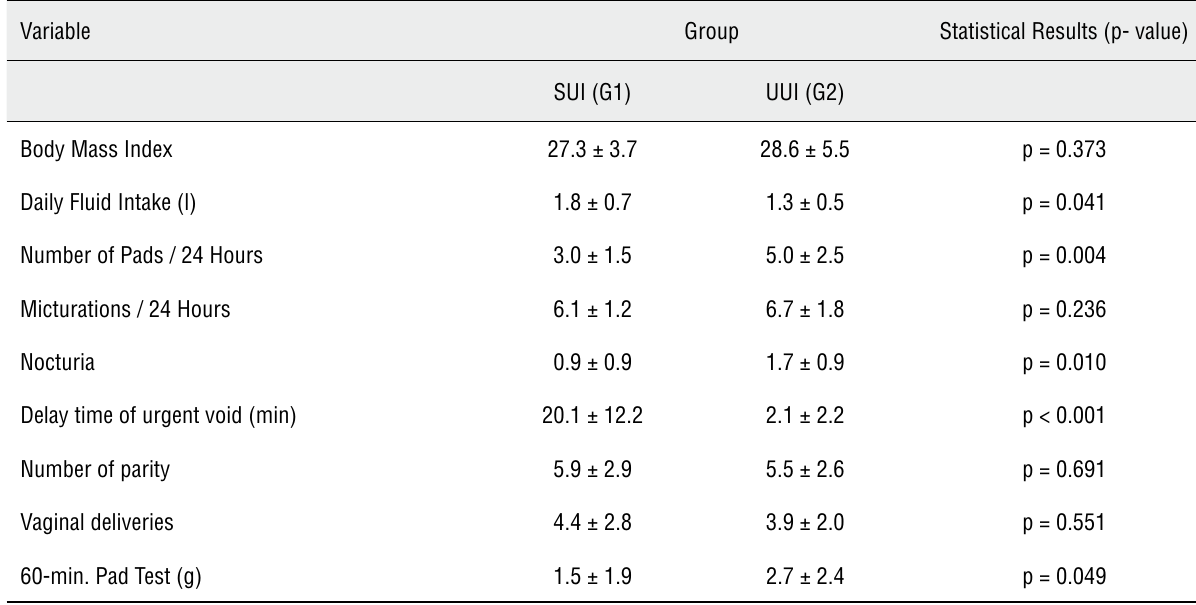
Table 1 - Population characteristics of patients with stress urinary incontinence (SUI) (n = 22) and urgency urinary incontinence (UUI) (n =